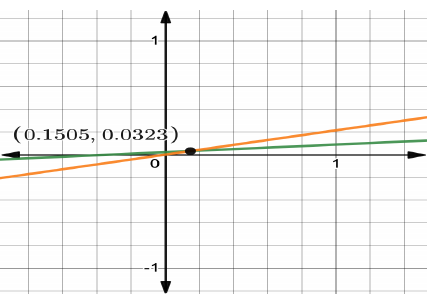
( x ) = 3 x + 1 (green) and G γ 2 45